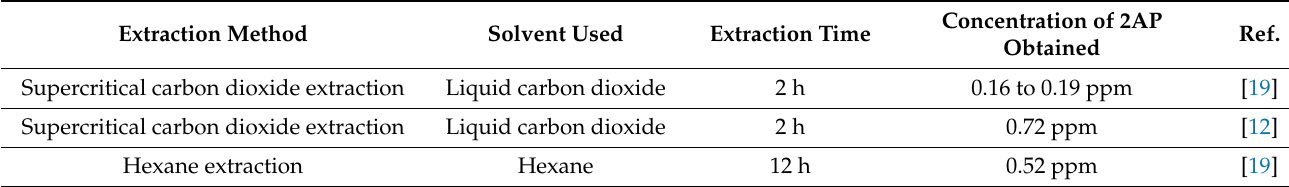
Table 6. Previous extraction methods used to extract